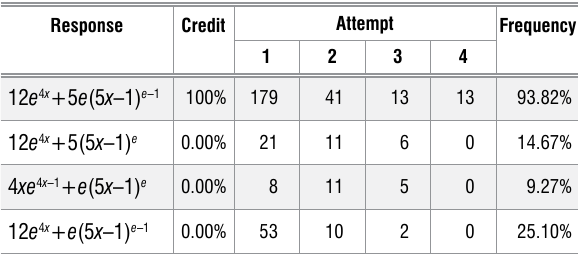
Analysis of student responses for Question 3 ( n = 261)